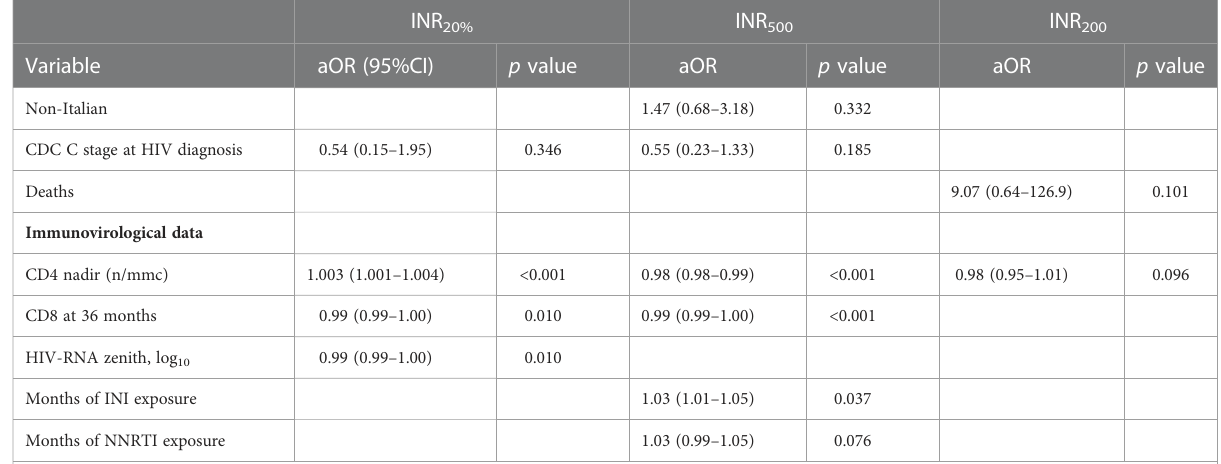
TABLE 5 Multivariable analysis of factors associated to INR 20% , INR 500 and INR 200 .